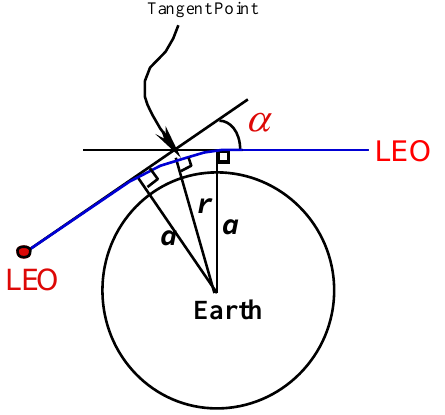
Fig. 1. ATOMMS occultation geometry.